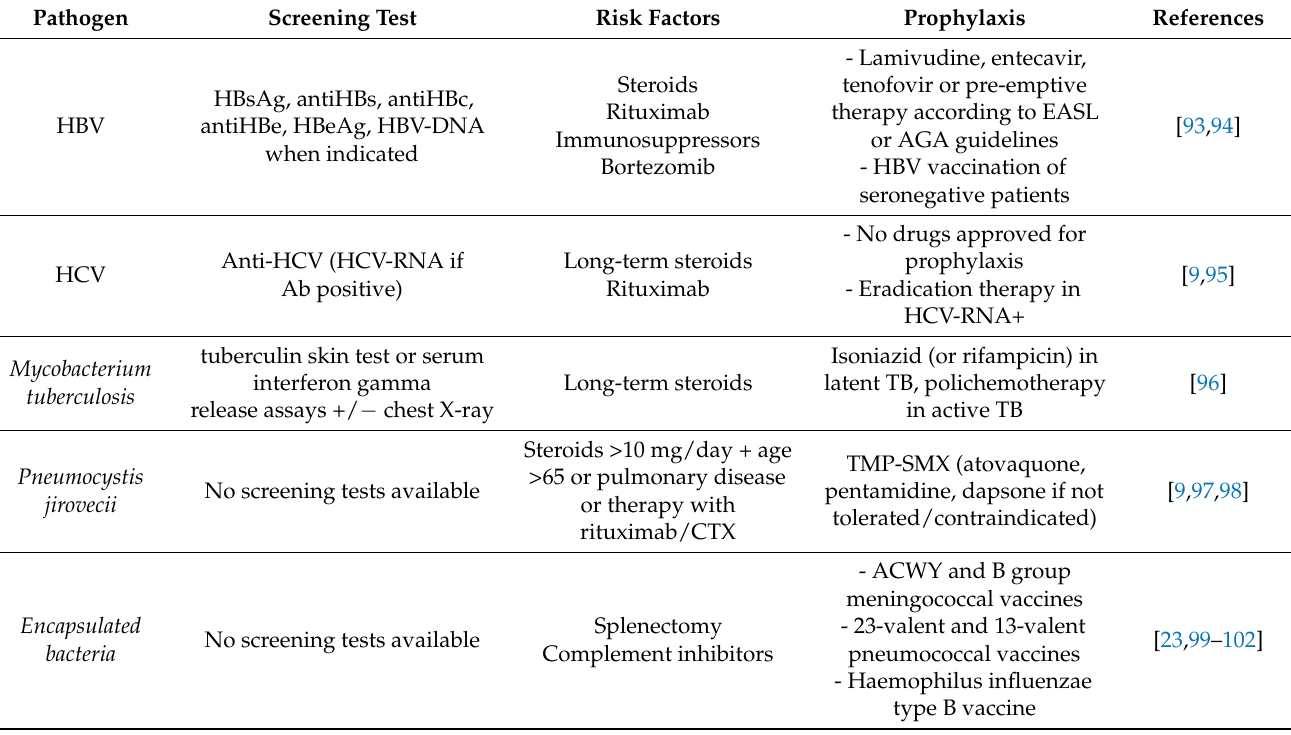
Table 3. Prevention strategies detailed per